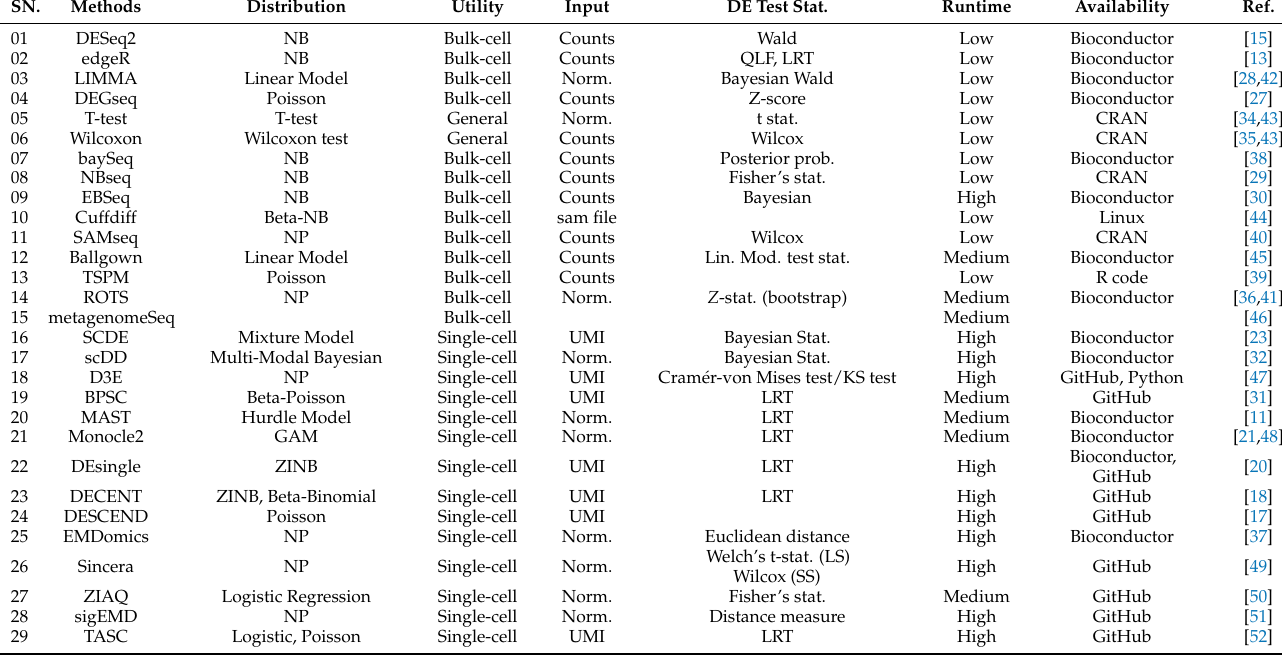
Table 1. Description of scRNA-seq DE